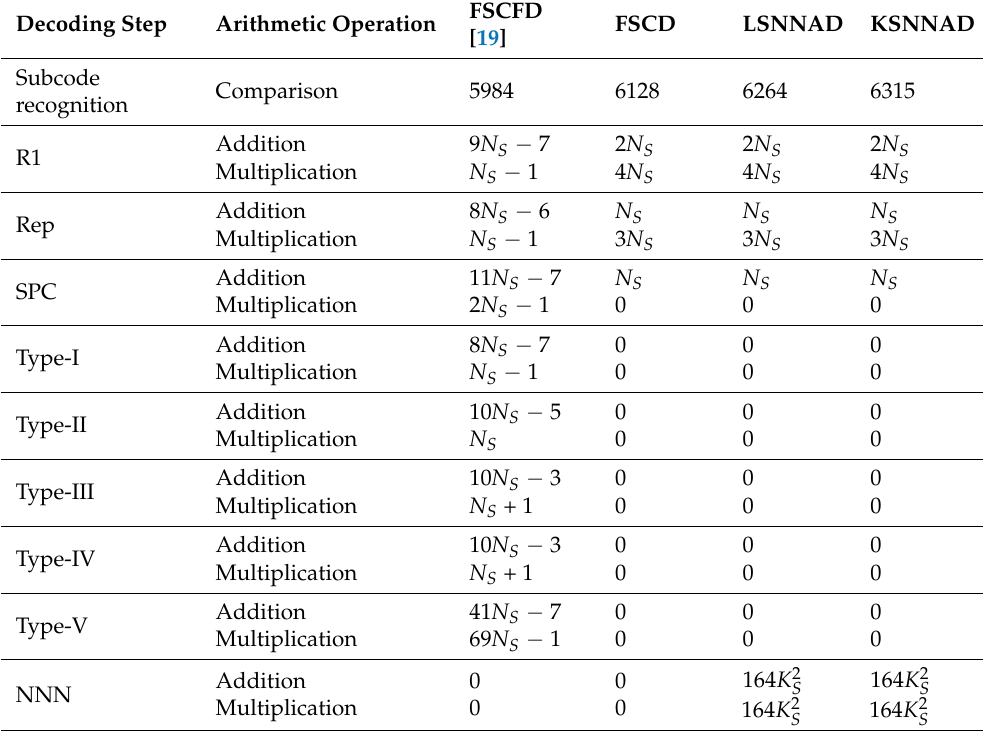
Table 3. Number of arithmetic operations for different decoding steps.